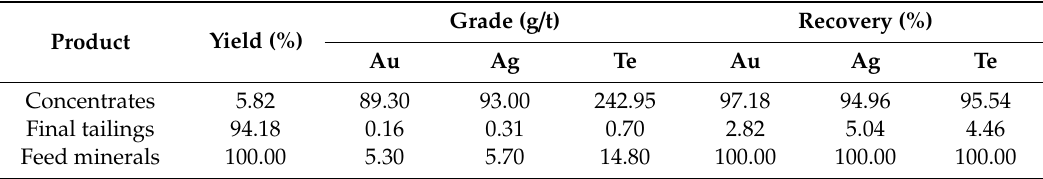
Table 4. Results of a closed-circuit flotation test.